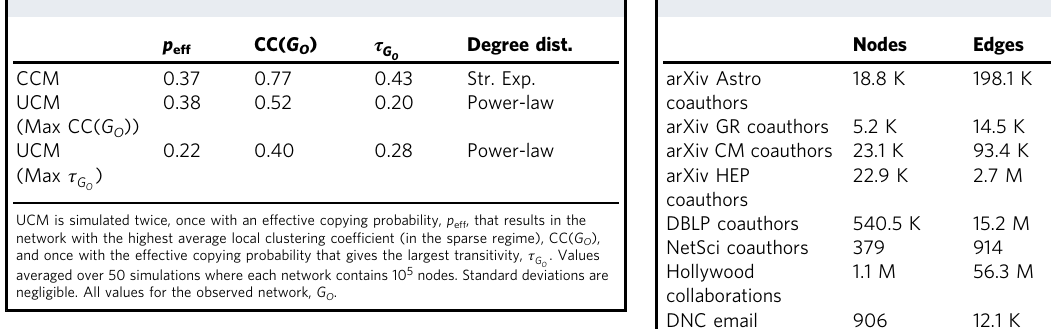
= 0.75, each network contains 10 5 nodes. For p = 1, each network contains 10 4 obs obs = 1, p = 0 corresponds to the CCM, see Fig. 2. If p = p hid obs hid obs , the GCCM is Table 2 A selection of sparse undirected networks which may plausibly grow via a copying